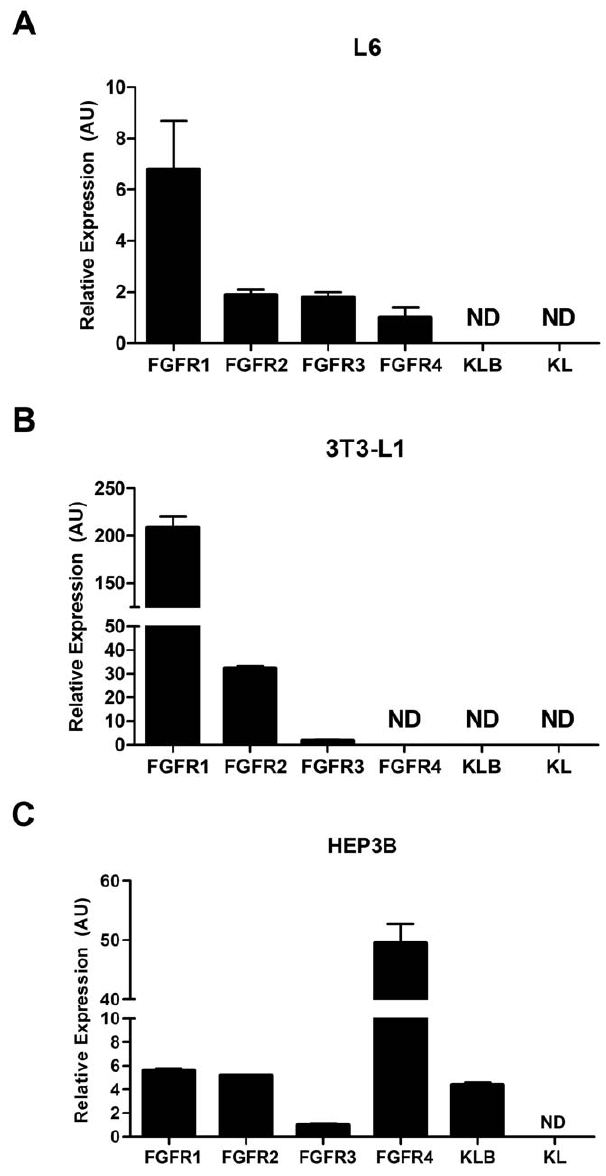
Figure 1. Expression of FGF receptors and Klotho co factors in cell culture models. In 3T3-L1 cells we found a high level of FGFR1 expression along with modest levels of FGFR2 and FGFR3. In these cells FGFR4, KL and KLB were not detectable (A). In Hep3B cells there was detectable expression of all 4 FGF receptor subtypes, however, we detected especially high levels of FGFR4. Hep3B cells were also found have appreciable expression of KLB while KL was not detectable (B). In L6 cells expression of all FGFRs was extremely low in comparison to other cells lines we screened in addition to undetectable levels of KLB at baseline